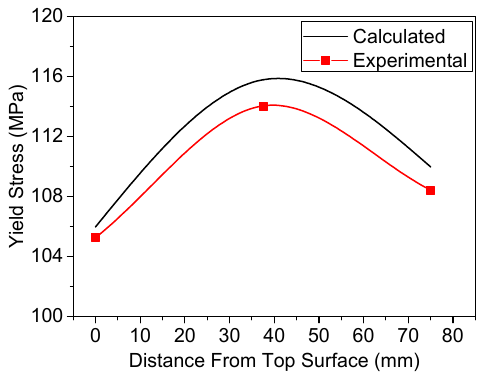
Figure 9. The strength distribution in the thickness direction.